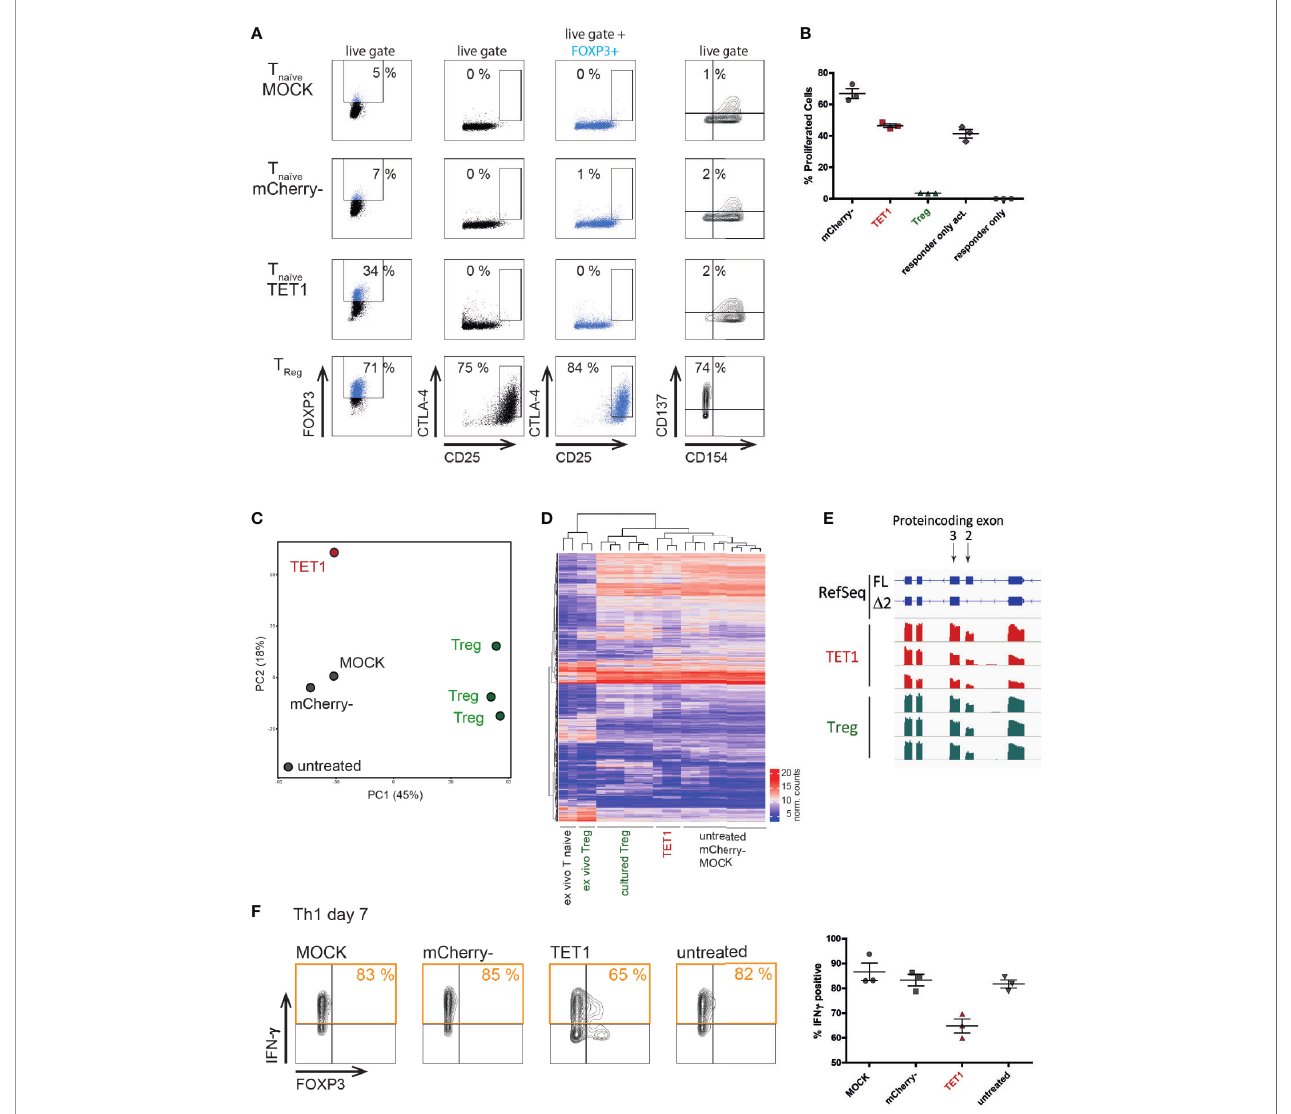
FIGURE 3 | Physiological FOXP3 expression induced by targeted TSDR de-methylation does not convert conventional T cells into functional Tregs. Successfully transfected mCherry+ naïve T cells ( “ TET1 ” ) on day 7 post transfection were analyzed for their surface protein expression, transcriptome and for their Treg function and compared to positive [ex vivo Treg and cultured Treg] as well as to negative controls (mCherry-, MOCK, untreated). (A) Expression of the known Treg markers FOXP3, CD25 and CTLA-4 in the indicated samples (black) or pre-gated on FOXP3+ cells (blue). Expression of CD137 and CD154 were stained after additional 2 days of rest and subsequent short-term TCR re-stimulation. One representative experiment of 3 is shown for each staining. (B) In vitro suppression assay to assess the suppressive capacity of TET1 and control cells on day 9 post transfection. The fraction of proliferating CD4+ responder cells in a co-culture system using the indicated populations (X-axis) as suppressor cells is given. The mean and SEM are indicated. One representative experiment of 2 is shown. (C) PCA of genome-wide transcriptomes (RNAseq). Shown is one representative experiment of n = 3. (D) Hierarchical clustering of samples from all three experiments based on the top 1000 differentially expressed genes. (E) Screenshot of a genome-browser view displaying FOXP3 expression in TET1 and Treg samples (n = 3 each). The coding exons 1 – 5 are shown to compare the relative fractions of the two annotated FOXP3 isoforms, full length (FL) and D exon 2 ( D 2) in both cellular subtypes. (F) Interferon g expression after short-term re-stimulation with PMA/ionomycin in transfected TET1 Th1 memory cells and controls. One representative experiment is shown in FACS plots, results of n = 3 are shown in the graph on the right, the mean and SEM are